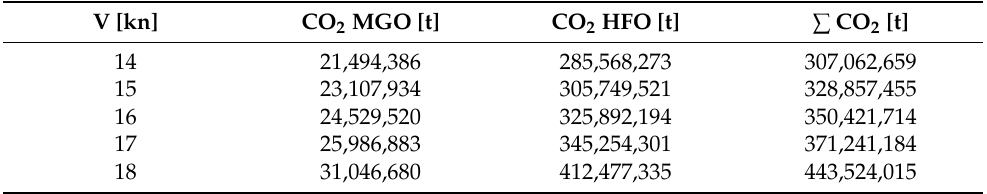
Table 13. Estimated amount of CO 2 emissions in container shipping under global cap conditions (i.e., 0.5% HFO fuel) for 2020.